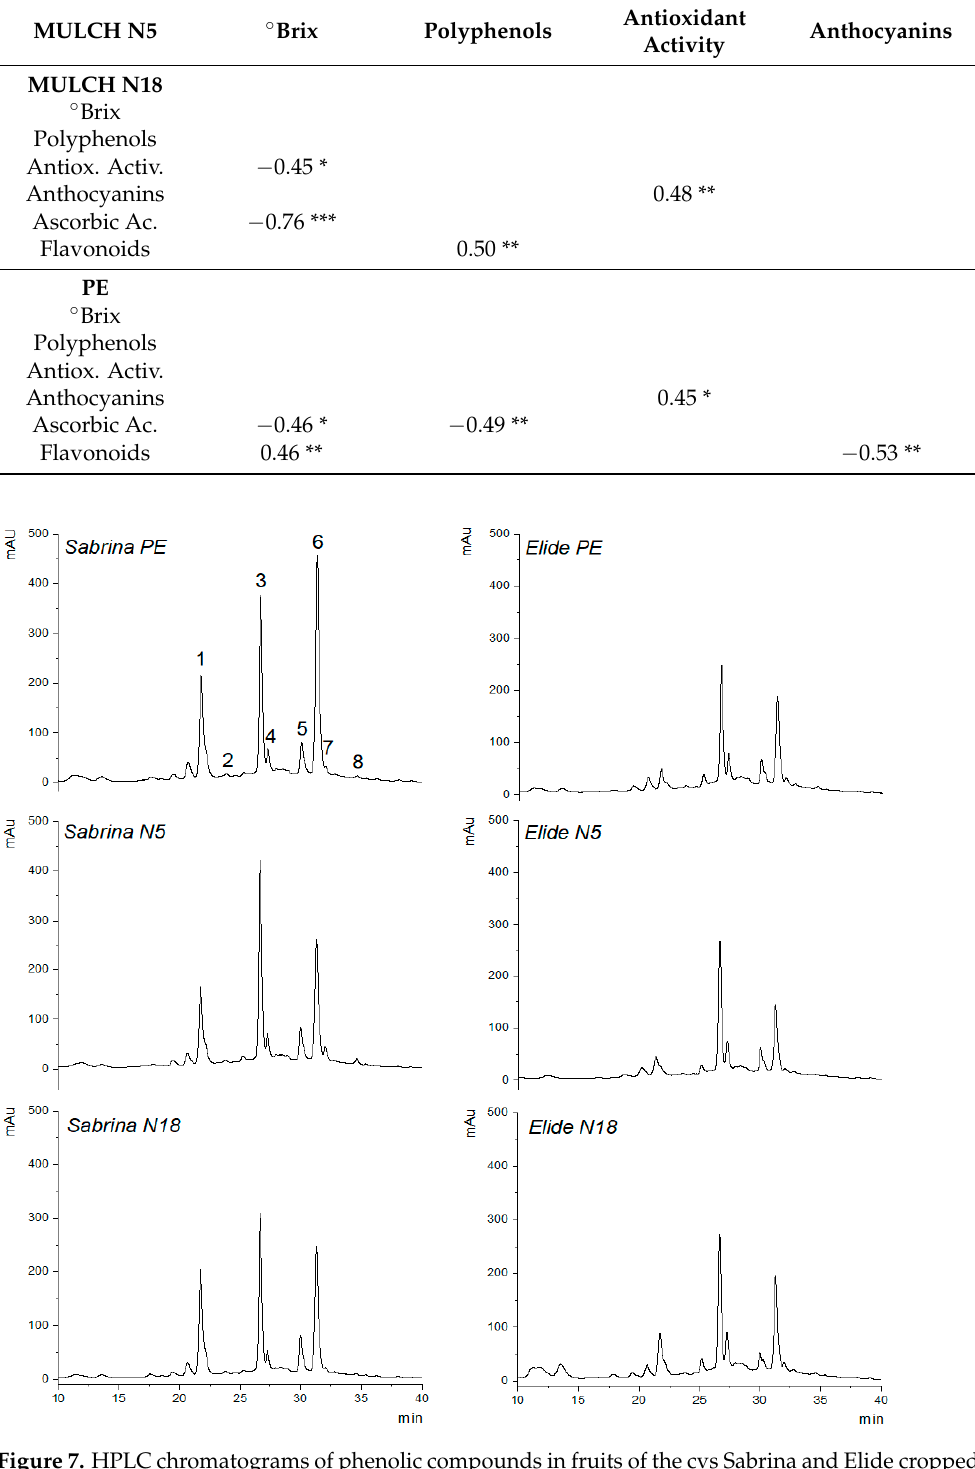
Figure 7. HPLC chromatograms of phenolic compounds in fruits of the cvs Sabrina and Elide cropped on PE, N5, and N18 mulching films .